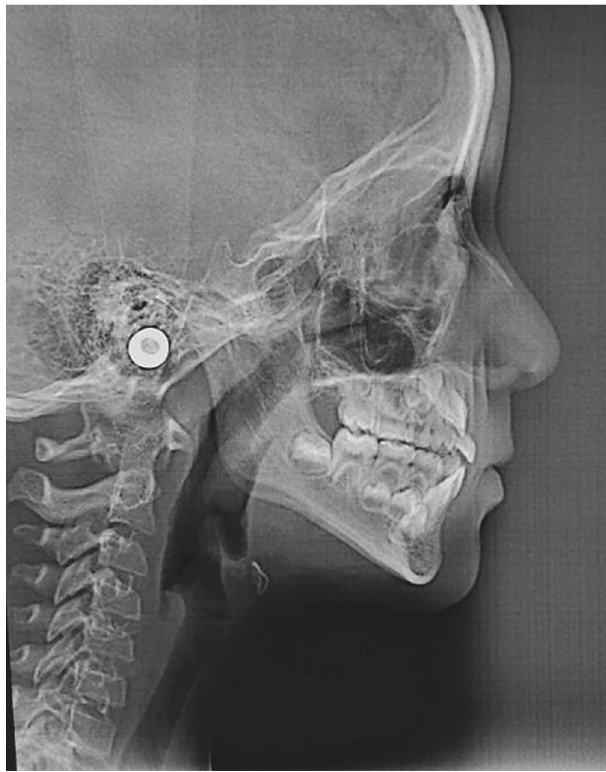
Figure 3: The lateral cephalic radiography shows skeletal Class III due to mild maxillary macrognathism.